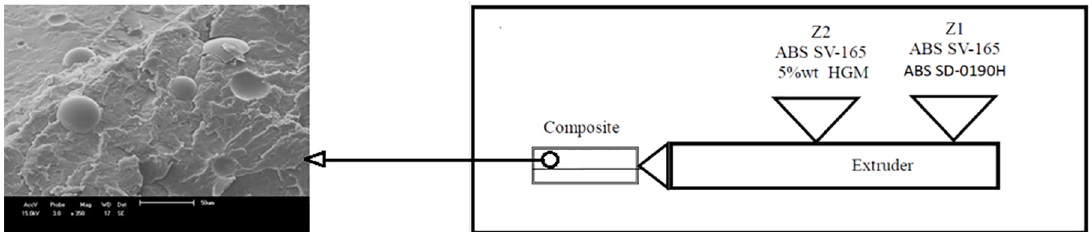
Figure 5. SEM micrograph of the composite with 5.0 wt.% ABS SV-165 (Z2) and ABS SV-165 + ABS SD-0190H(Z1). Graphical